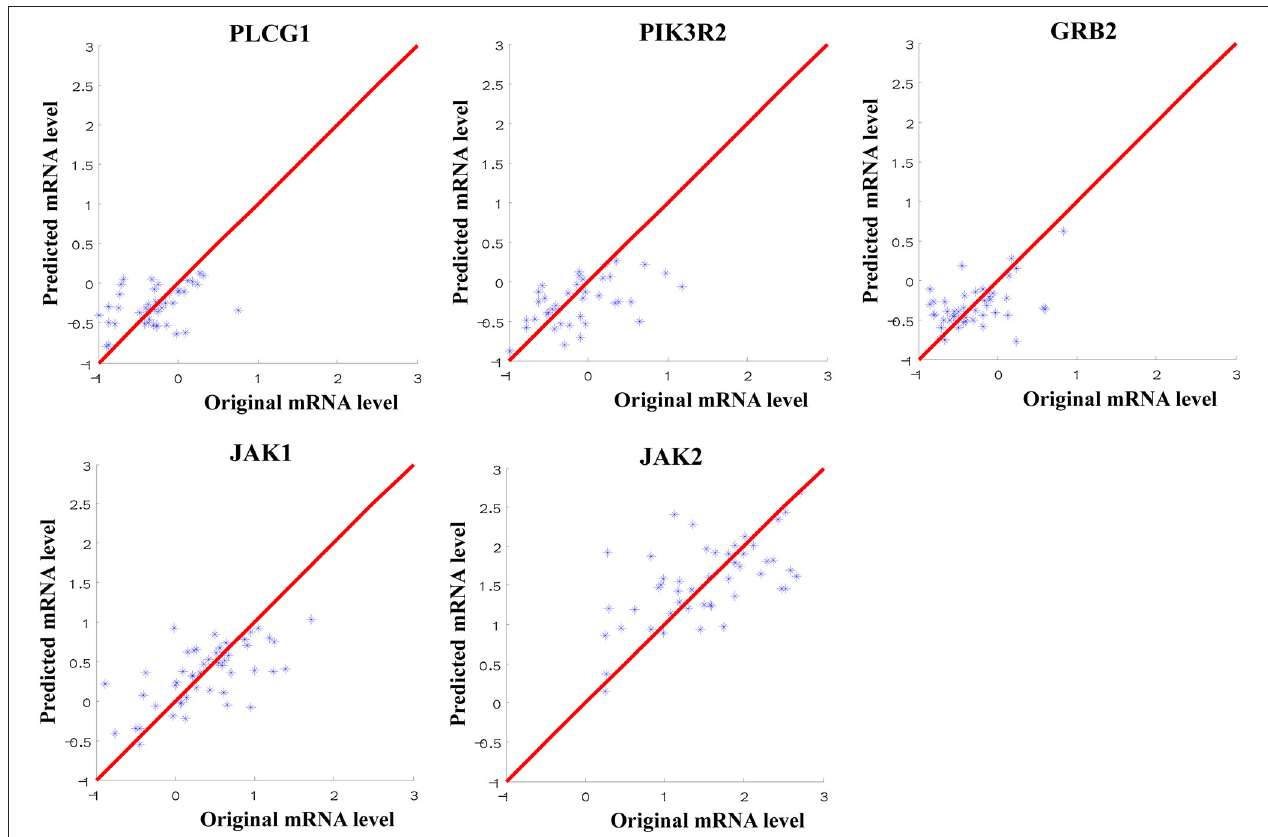
FIGURE 3 | Scatter diagram for the expression levels of the original mRNAs from microarray data and the predicted mRNAs from SVR models. The red line referred to Y = X to indicate the location of the data